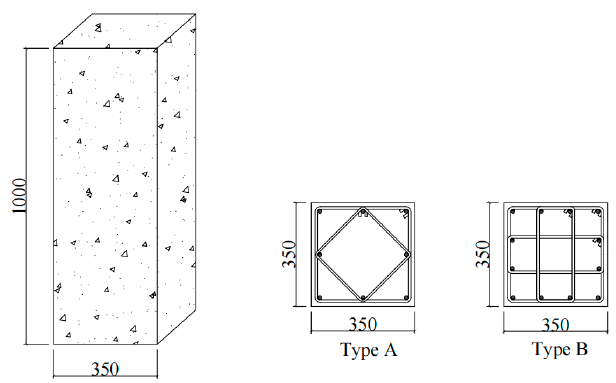
Figure 2. Specimen size and section reinforcement.